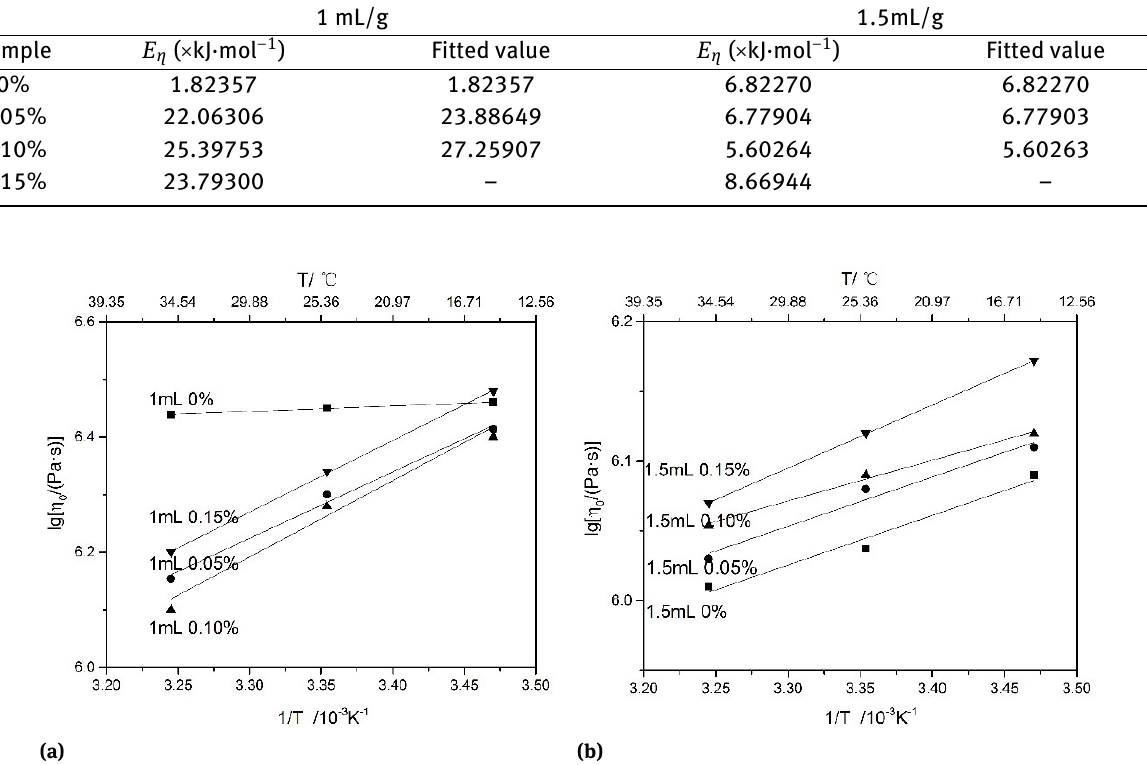
creased. However, when the ratio of solvent became